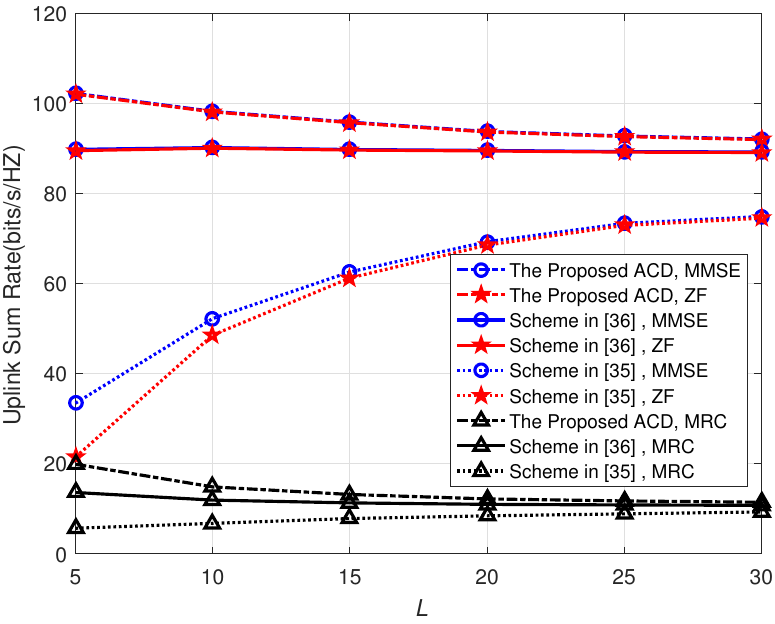
Figure 9. Uplink sum rate of the three schemes versus L